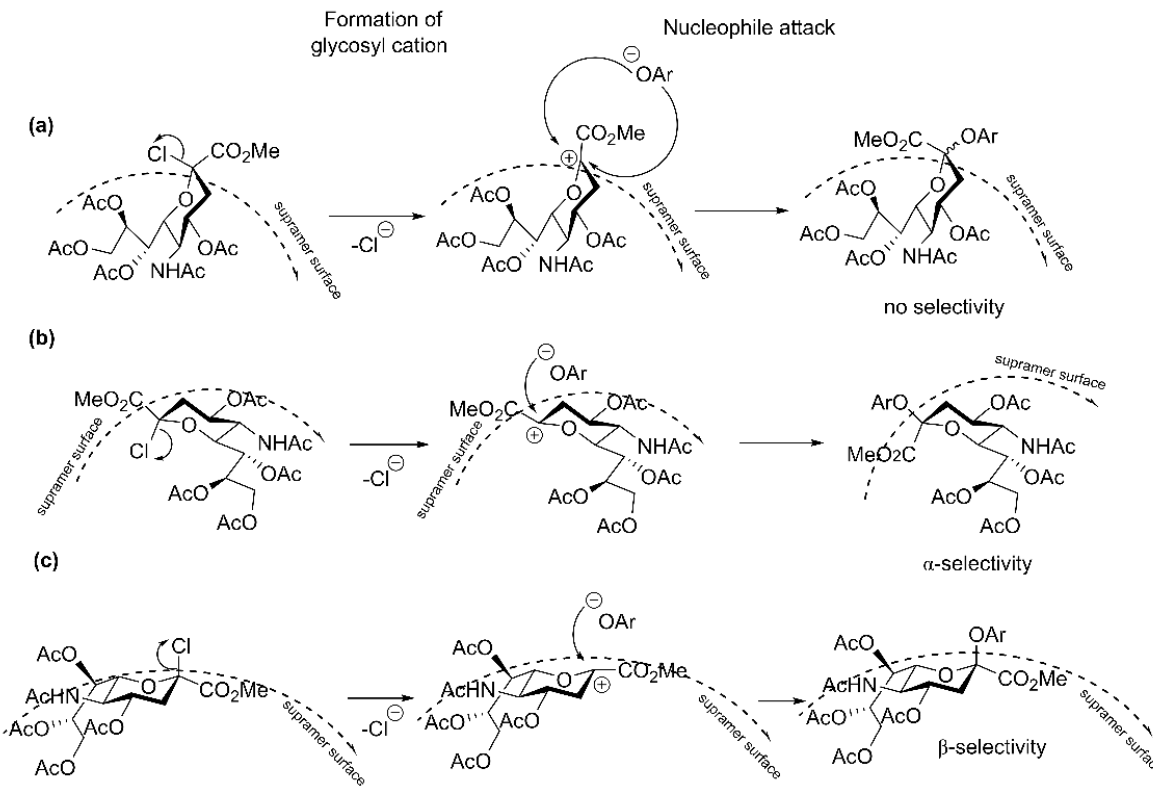
Figure 5. Possible presentations of N -acetylsialyl chloride 1 molecule on the surface of a supramer (dashed line): ( a ) Type I supramers; both sides of a glycosyl cation formed from N -acetylsialyl chloride 1 are accessible for the attack of a nucleophile leading to unselective reaction. ( b ) Type II supramers and ( c ) type III supramers; only one side of a glycosyl cation formed from N -acetylsialyl chloride 1 is accessible for a nucleophile attack leading to formation of one anomer only (α or β, respectively).